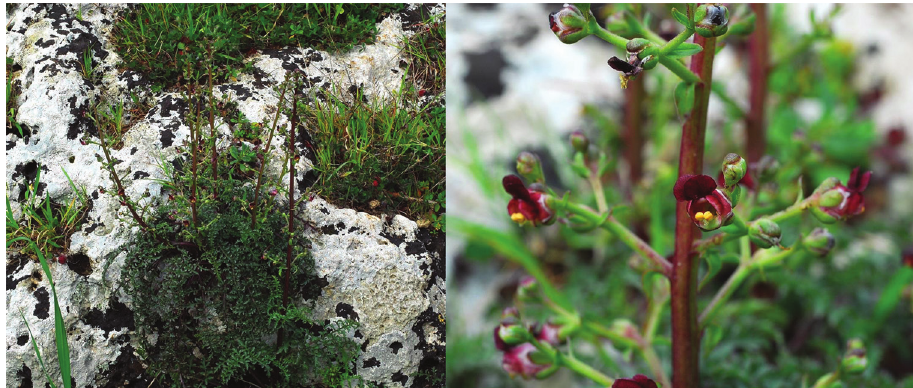
Figure 7. Scrophularia lucida photographed at Fasano (Brindisi). Photograph by E.V. Perrino.